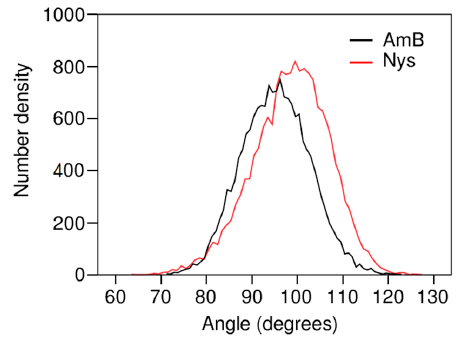
Figure 13. Bead4-Bead7-COM angle distribution for the encapsulated AmB and Nys.